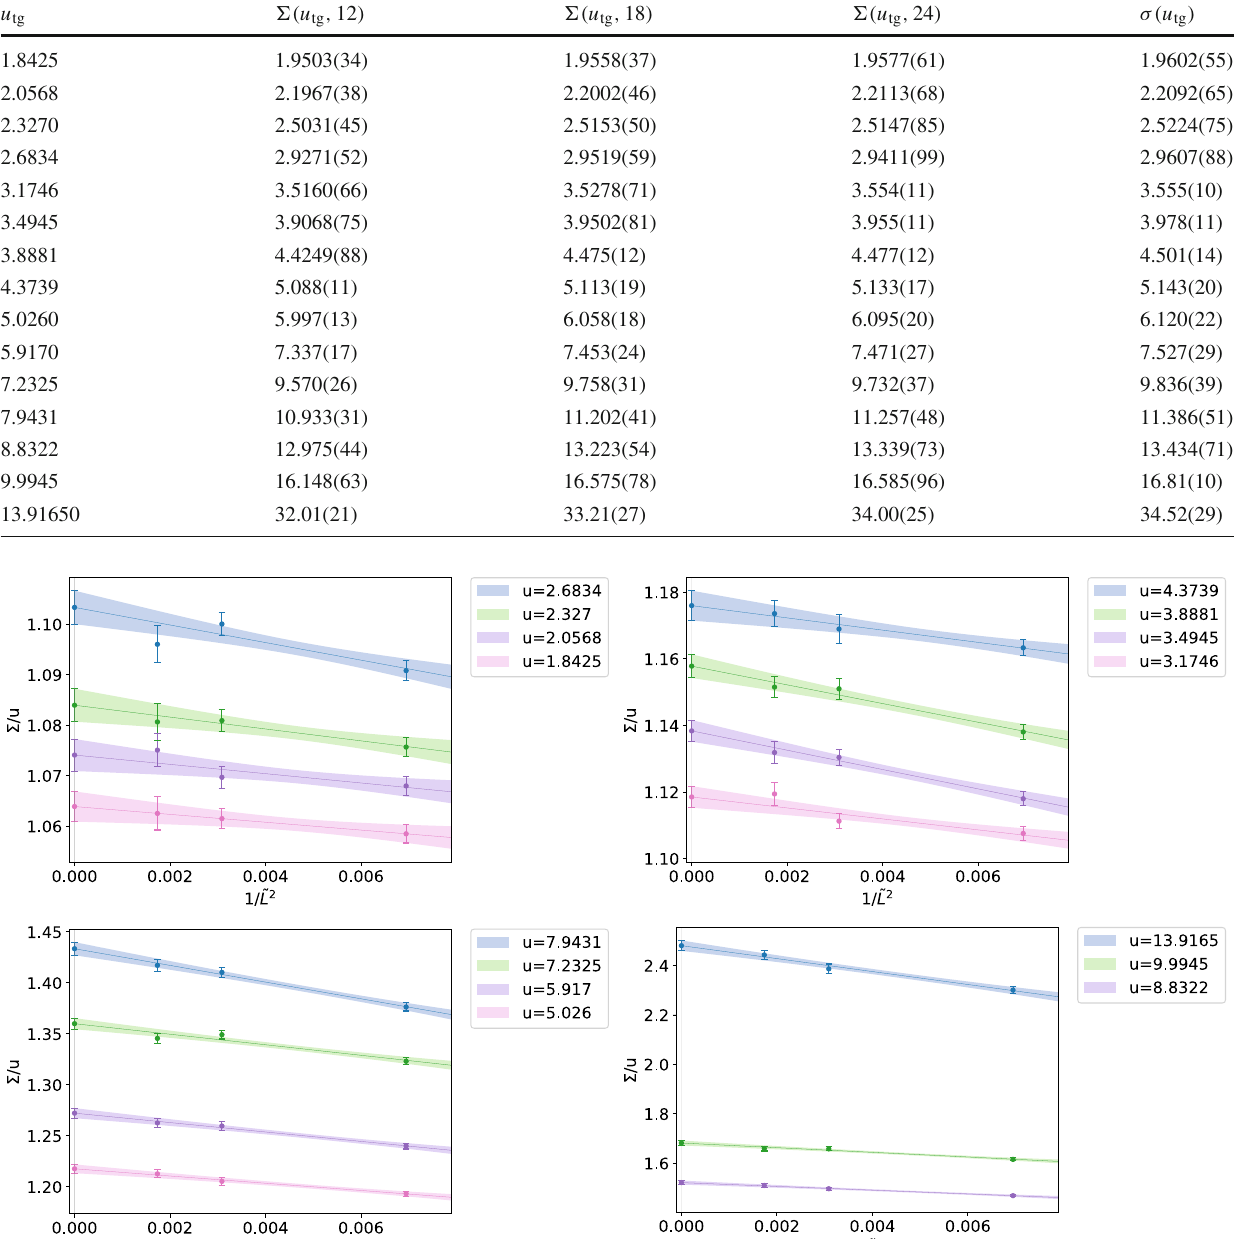
Table 1 Values of the lattice step scaling function (cid:13)( u tg , ˜ L ) at fixed targeted values of the coupling u tg and for different values of ˜ L . We also report on the continuum extrapolation σ( u tg